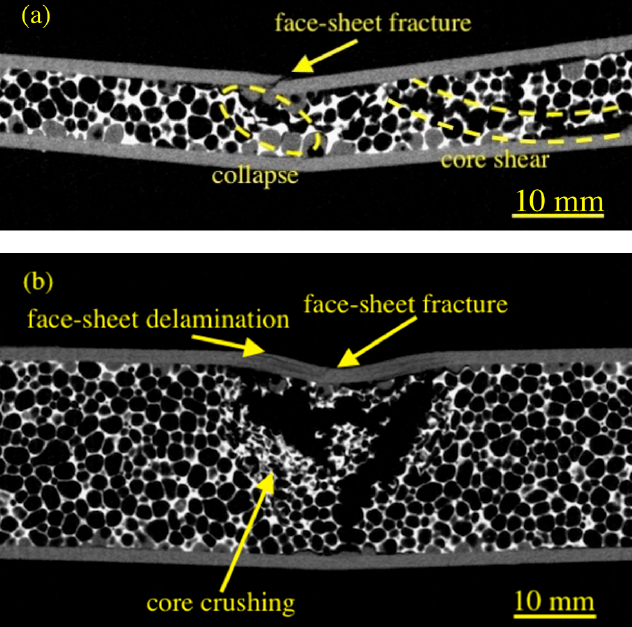
Figure 11. Tomographic images: ( a ) #10-0.37; ( b ) #30-0.37.